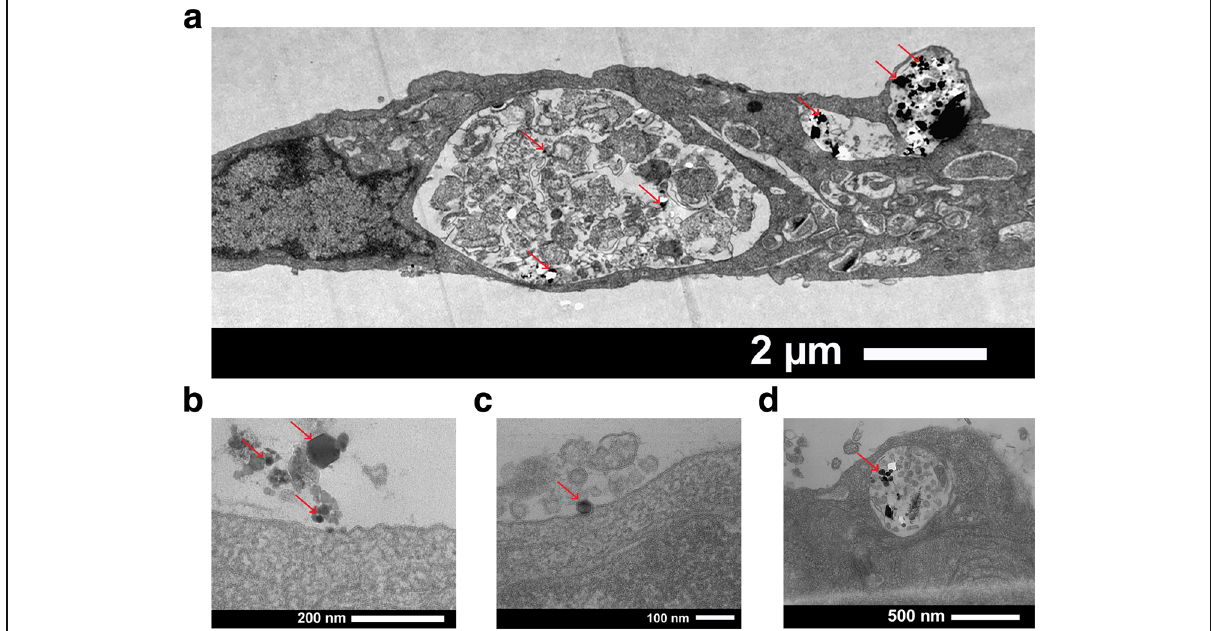
Fig. 3 TEM pictures taken from a single endothelial cell incubated with GaN/Fe nanoparticles. a Nanoparticles distribution within cellular vesicles. b – d The uptake process of nanoparticles into vesicles. Red arrows indicate nanoparticles that appear darker in TEM due to high atomic density compared to biological media